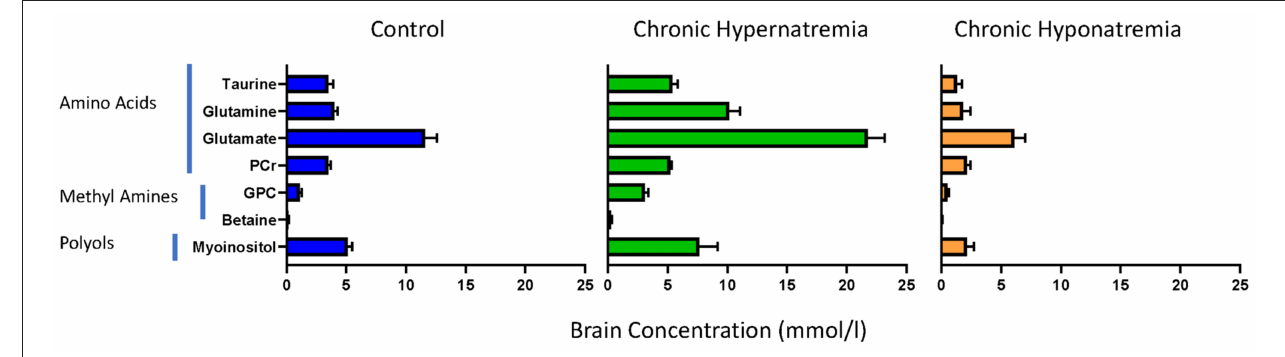
FIGURE 1 | Brain organic osmolytes by chemical class in normal rats (left, N = 8) and rats exposed to chronic hyponatremia (right, N = 6) and hypernatremia (middle, N = 6). From references (4, 16).